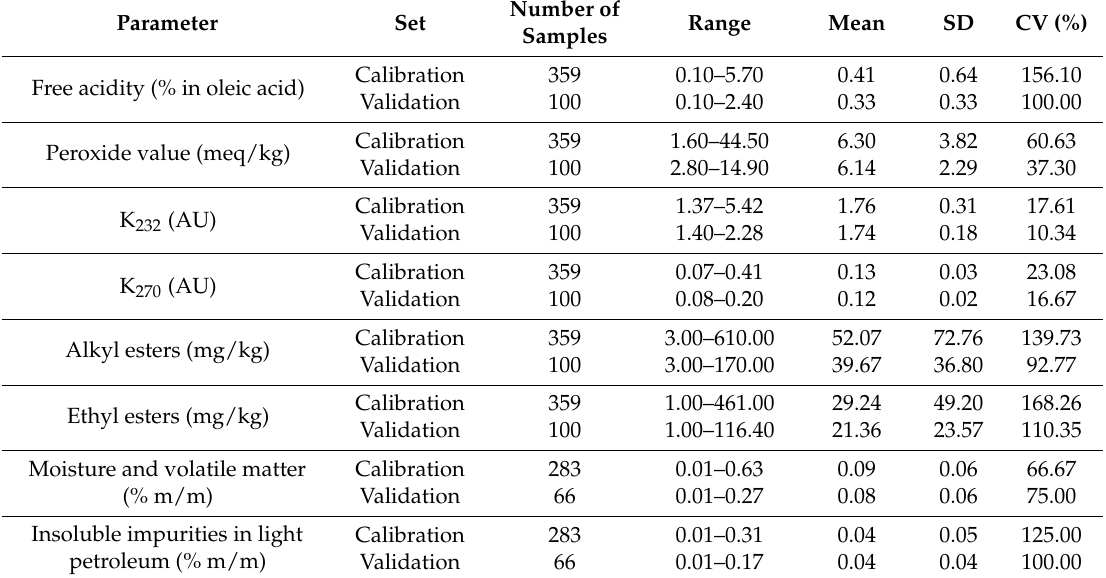
Table 1. Statistical analysis of calibration and validation sample sets: data range, mean, standard deviation (SD) and coefficient of variation